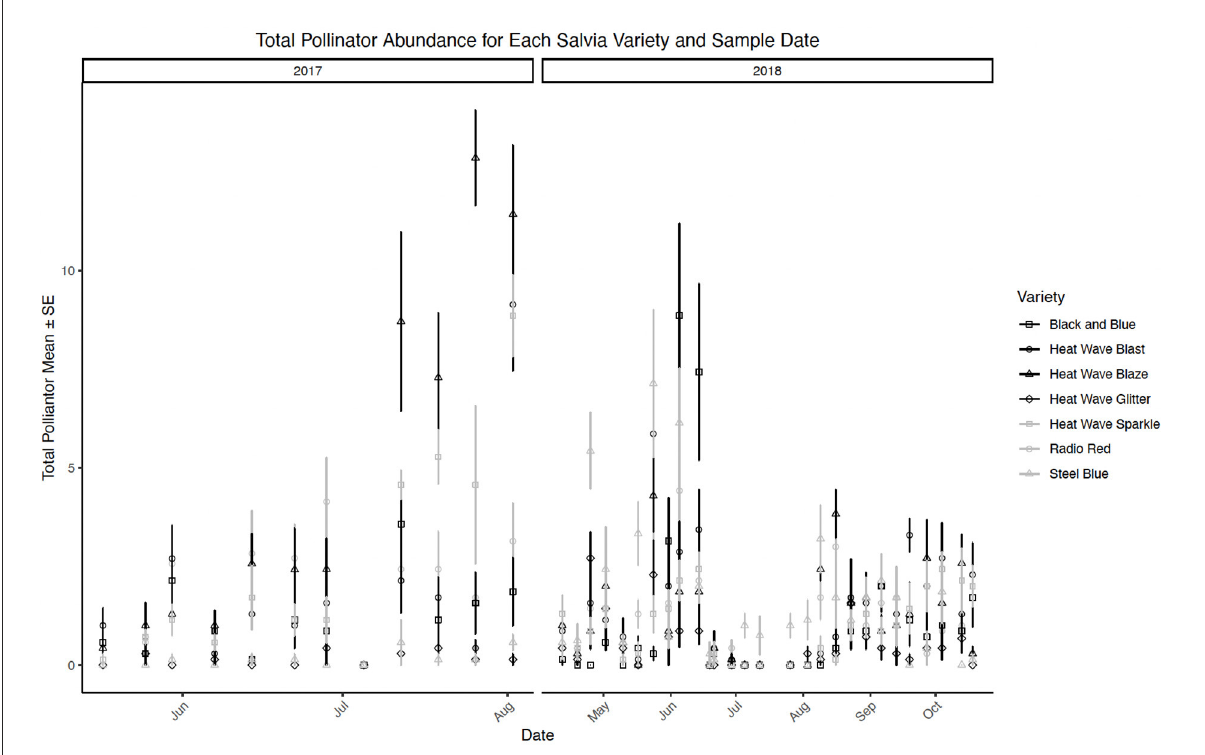
FIGURE8 Mean ± se total flower visitors (pollinators) comparison among salvia cultivars by date in a 2-year study in central Georgia,